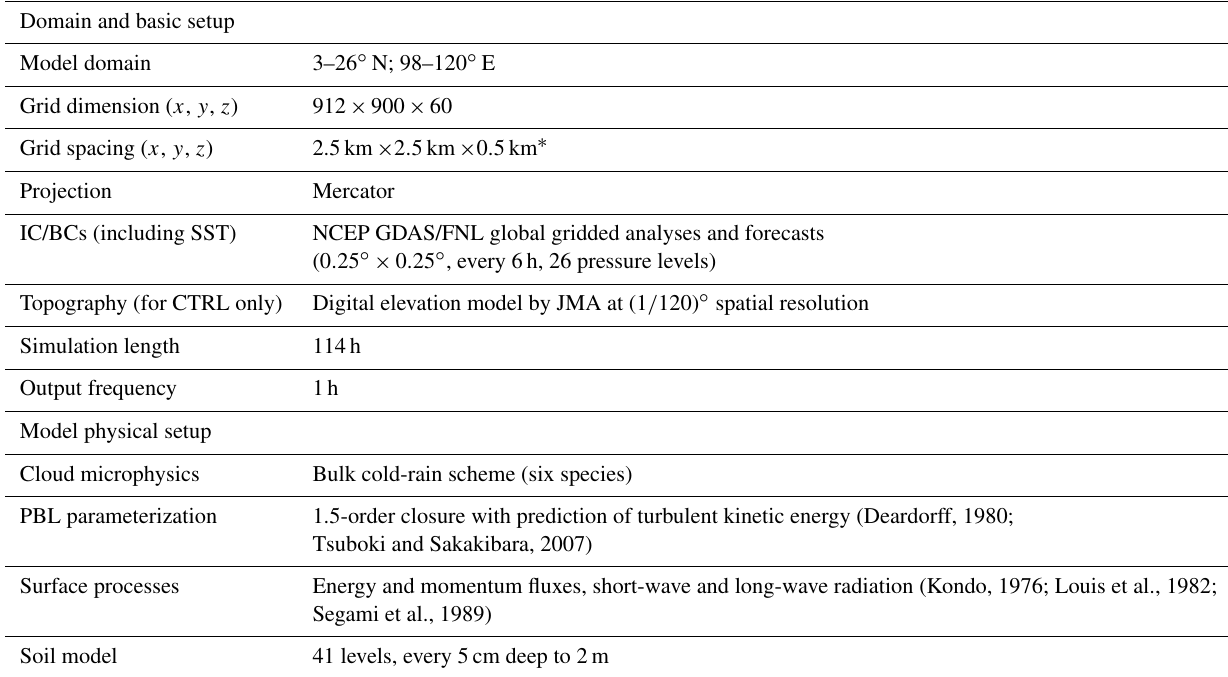
Table 1. The basic information of experiments. Domain and basic setup